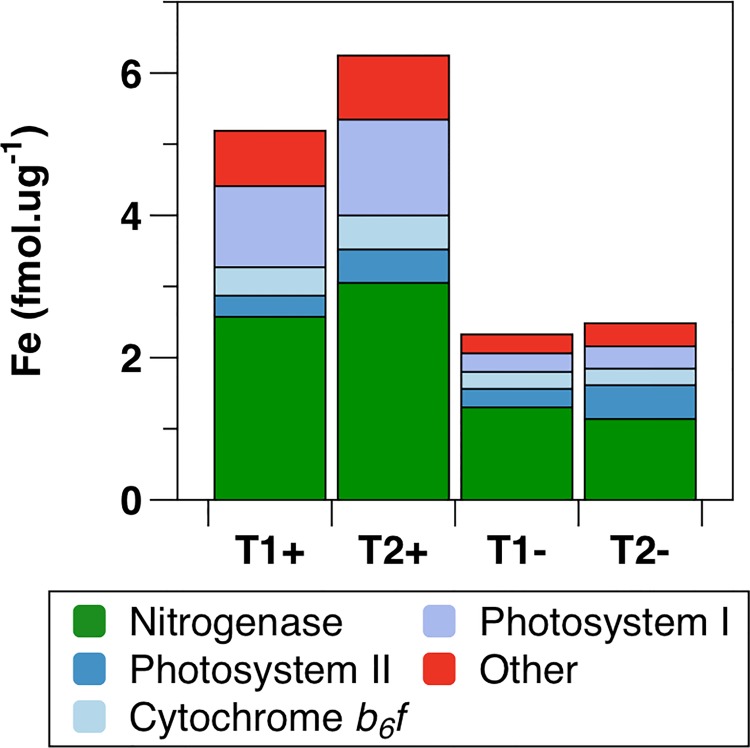
Total predicted protein associated Fe.Total protein derived Fe concentration for each of the four experimental treatments (T1+, T2+, T1- and T2-) expressed as fmol Fe ug-1 total protein. Fe concentration is subdivided into the major Fe containing complexes: Nitrogenase, cytochrome b
6
f, PSII, PSI and other.